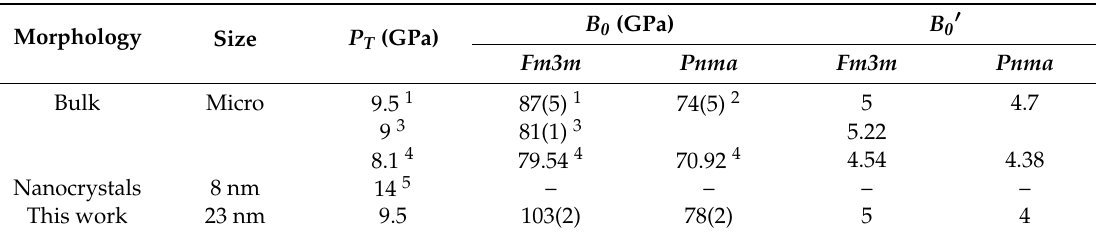
Table 1. Transition pressure ( P T ), and equation of state parameters ( B 0 and B 0 (cid:48) ) of fluorite-type and α -PbCl 2 -type CaF 2